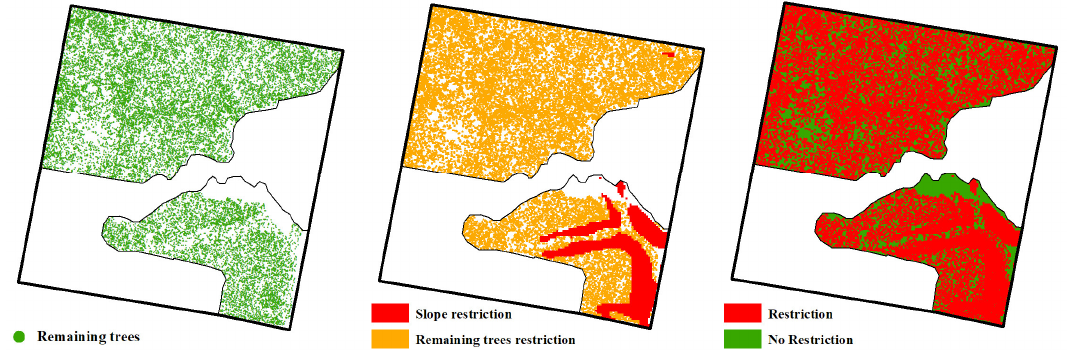
Figure 4. Vector of remaining trees, intersection between remaining trees constraint and slope constraint, and the resulting vector with restricted and non-restricted areas to yards’ allocation.